Question: In a single sentence, describe what this figure presents.
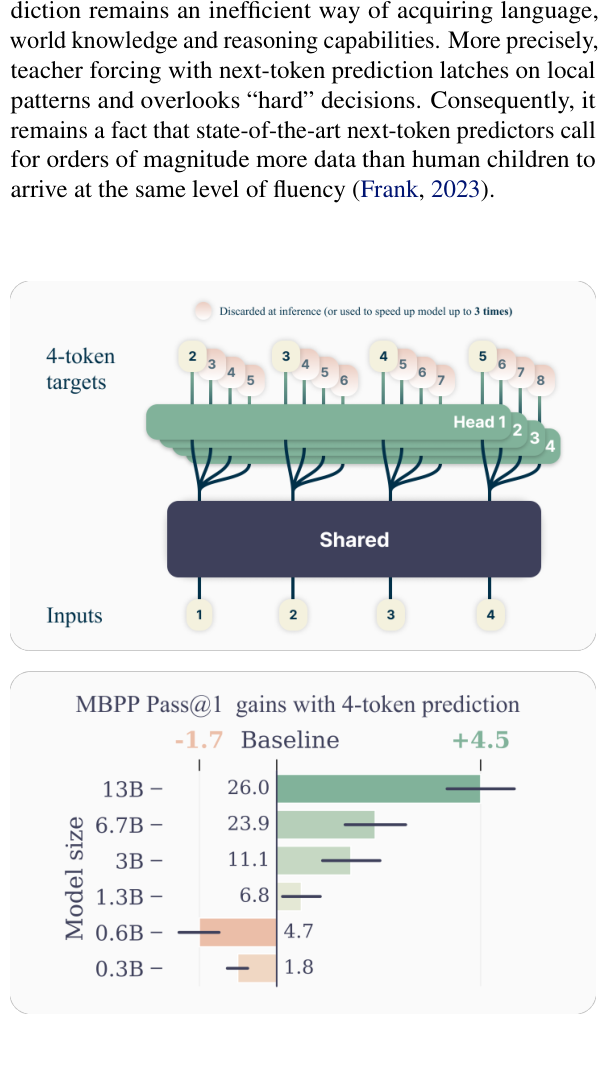
Answer: Overview of multi-token prediction. (Top) Dur- ing training, the model predicts 4 future tokens at once, by means of a shared trunk and 4 dedicated output heads. Dur- ing inference, we employ only the next-token output head. Optionally, the other three heads may be used to speed-up inference time. (Bottom) Multi-token prediction improves pass@1 on the MBPP code task, significantly so as model size increases. Error bars are confidence intervals of 90% computed with bootstrapping over dataset samples.